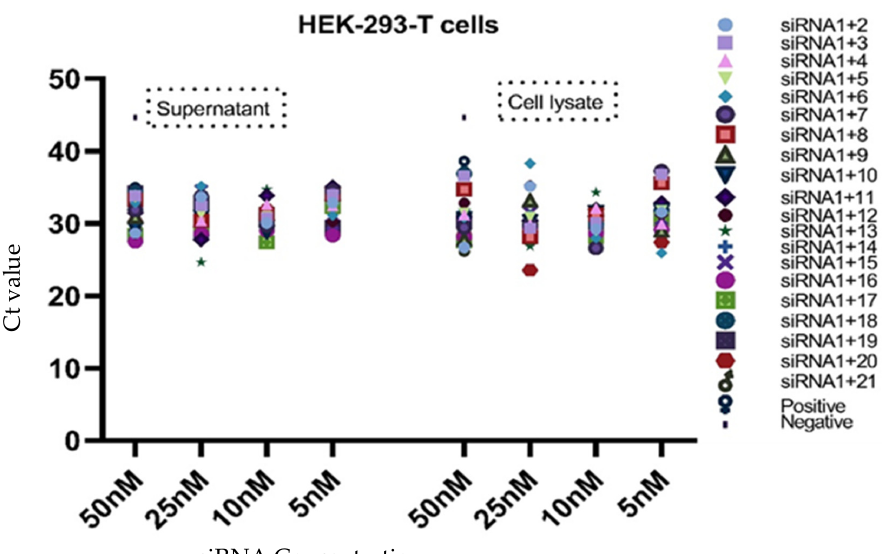
Figure 4. Presentation of the Ct values of combined use of siRNAs in both the cell lysate and supernatant of HEK-293-T cells. The graph shows that a few siRNAs exhibited better potential compared to other combinations (50,25, 10, and 5 nM). The highest Ct value was 45, which occurred in the negative control sample. Table 5. Ct values of qPCR results of siRNA combinations in Huh-7 cells.